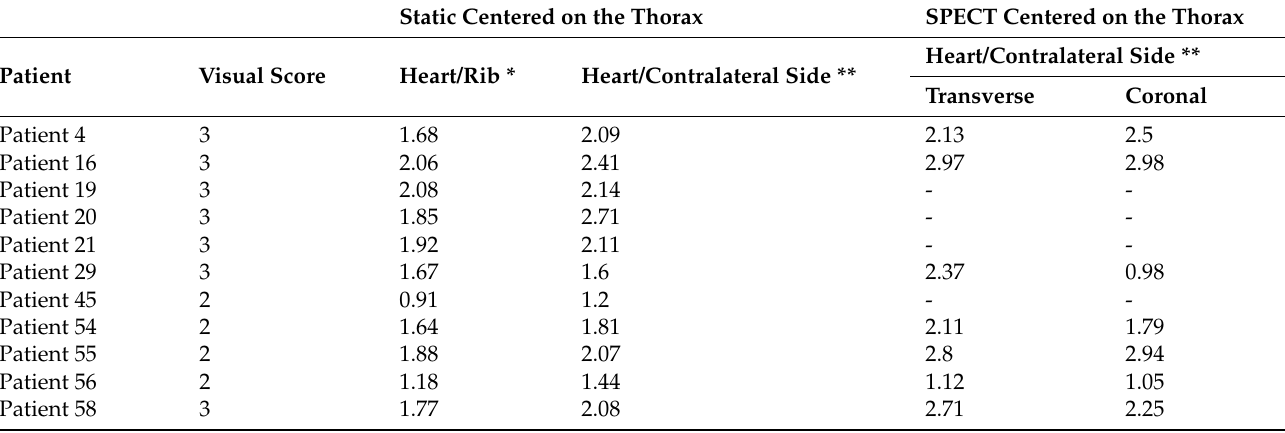
Table 4. Semiquantitative Method, ATTR positive results: comparing ratio results of static im- ages with SPECT images; * heart/rib: >1 = ATTR, <1 = AL, 1 = possible ATTR in an early form; ** heart/contralateral region: 0–1.49 = AL, 1.5–3 =